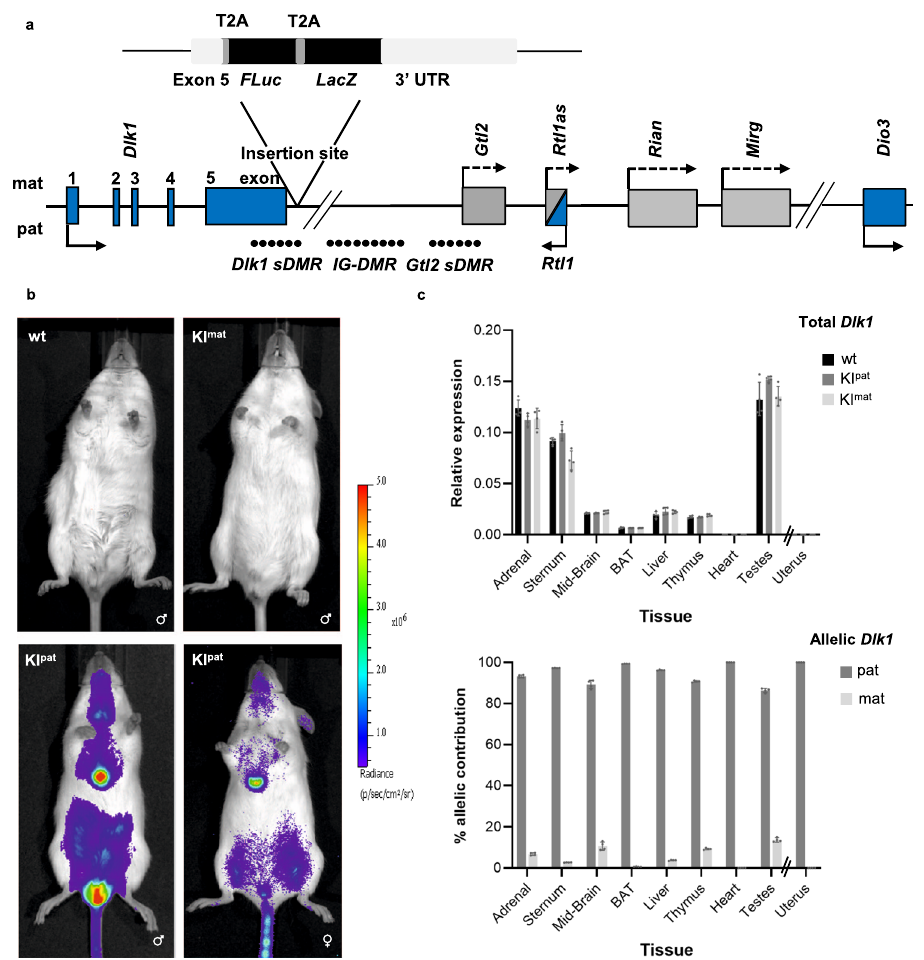
Fig. 1 Generation and characterisation of reporter mice for imprinted Dlk1 expression. a Schematic of the mouse Dlk1-Dio3 imprinted locus showing reporter insertion. Three differentially methylated regions (DMRs) that regulate imprinted expression of the cluster are indicated (closed circles represent methylated CpGs, IG-DMR , Dlk1 sDMR and Gtl2 sDMR ) and the position of maternally expressed (light grey) and paternally expressed (blue) genes are shown. Arrows depict transcriptional direction, with solid lines representing protein-coding genes and striped lines representing non-coding transcripts. In the Dlk1-FLucLacZ reporter line, fi re fl y Luciferase ( FLuc ) and β – galactosidase ( LacZ ) were knocked into the endogenous Dlk1 locus, with T2A sites, downstream of exon 5. b Bioluminescence (BL, blue) was detected in 8-week-old (P56) male (lower panel, left) and female mice (lower panel, right) after paternal transmission of the reporter (KI pat ). Strong BL signal was evident in the thymus, central sternum and testes. Minimal signal was detected in animals after maternal reporter transmission (KI mat , upper panel, right) or in wild-type animals (wt, upper panel, left). c Dlk1 expression analysed by QRT-PCR (upper panel) was compared in different tissues from P56 male mice that inherited the reporter paternally (KI pat , dark grey), maternally (KI mat , light grey), or in non-transgenic controls (wt, black). Uterus samples from age-matched female mice were also analysed. Expression levels were normalized to β -Actin , 18S and Hprt expression (bars show the geometric mean of relative expression, error bars represent the geometric standard deviation (geometric SD)). Genotype had no signi fi cant effect on Dlk1 expression (Two-way ANOVA on delta-Ct values (Tissue p < 0.0001, Genotype p = 0.86, Interaction p = 0.98); N = 4 + 4 + 4 individual mice). Allelic Dlk1 analysis in KI mat mice (lower panel), using primers that distinguish the reporter from the wt allele, showed a strong bias for paternal allele expression (dark grey) compared to maternal allele expression (light grey). (Bars indicate the mean contribution from each allele ±SD; N = 4 + 4 individual mice). Source data are provided as a Source Data fi paternally expressed imprinted gene. Collectively these results reaf fi rm that Dlk1-FLucLacZ mice are reliable models of imprinted Dlk1 expression.